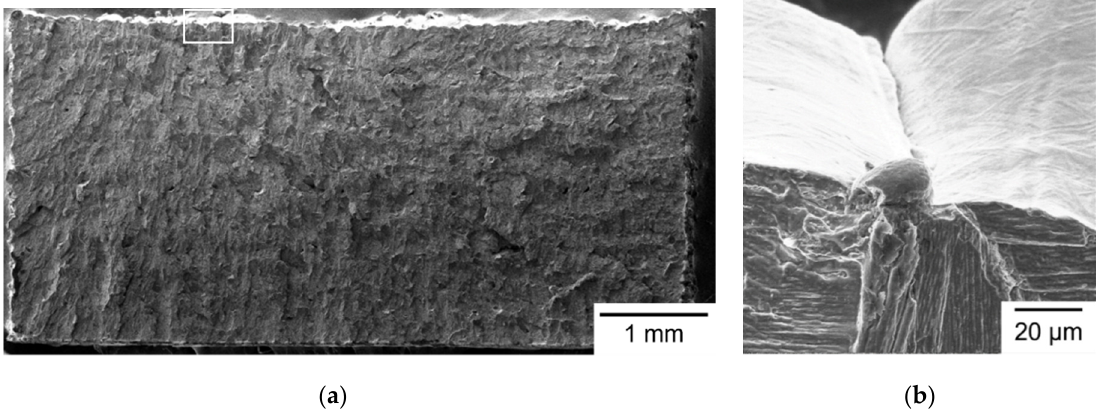
Figure 4. Fractography of a Group S1 specimen observed by SEM: ( a ) whole fracture surface; ( b ) fracture origin outlined in ( a ).